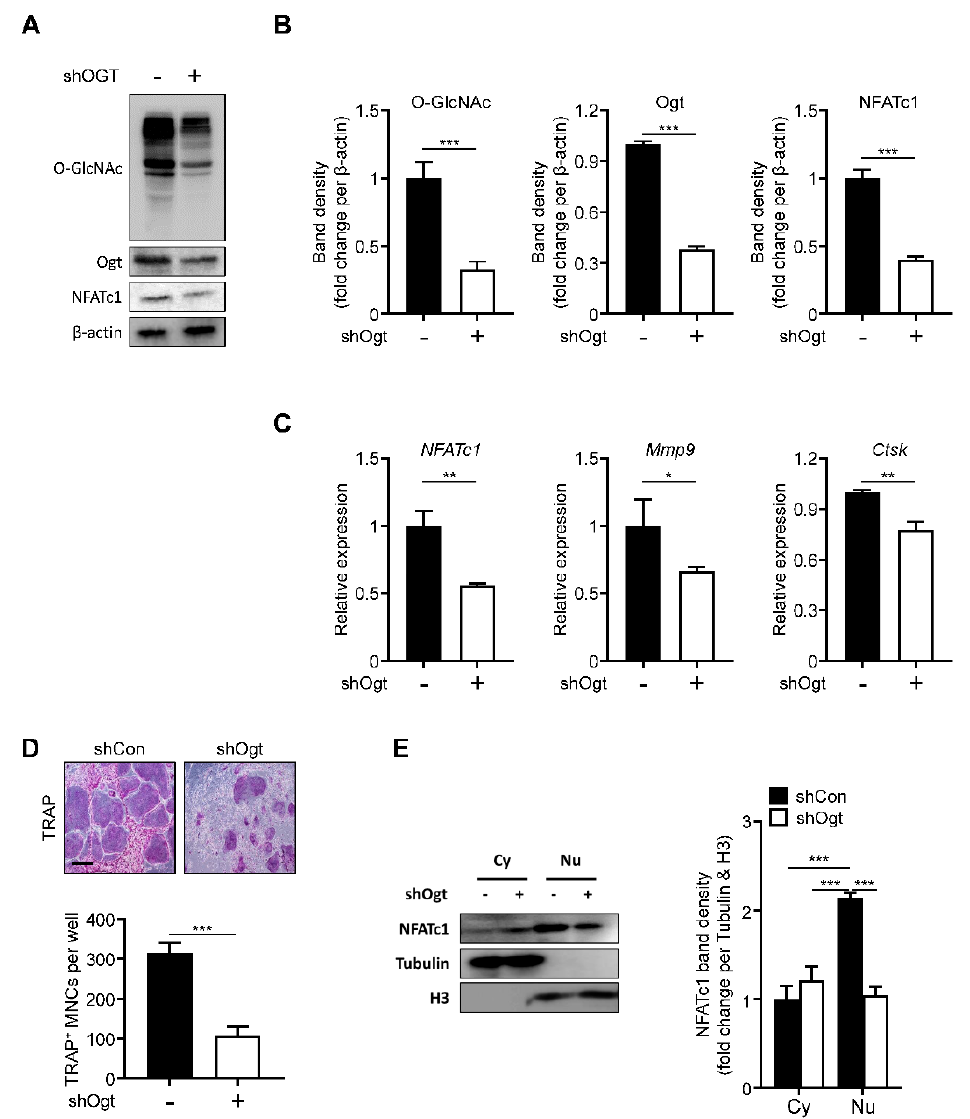
Figure 4. Ogt knockdown inhibits osteoclastogenesis. Infection of BMMs was performed with Ogt-targeted and control shRNA. After 48 h, the protein and mRNA expression levels were determined by ( A ) Western blot, ( B ) band density, and ( C ) RT-qPCR. ( D ) After 96 h, the TRAP-positive multinuclear cells were decreased by shOgt. Scale bar, 200 µ m. ( E ) Cytosolic and nuclear proteins were extracted for infected BMMs by shOgt for 48 h to determine translocation of NFATc1. The band density was quantified (left panel). Statistical data are presented as the means ± S.E.M. (* p < 0.05, ** p < 0.01 and *** p < 0.001, as measured by Student’s t -test).